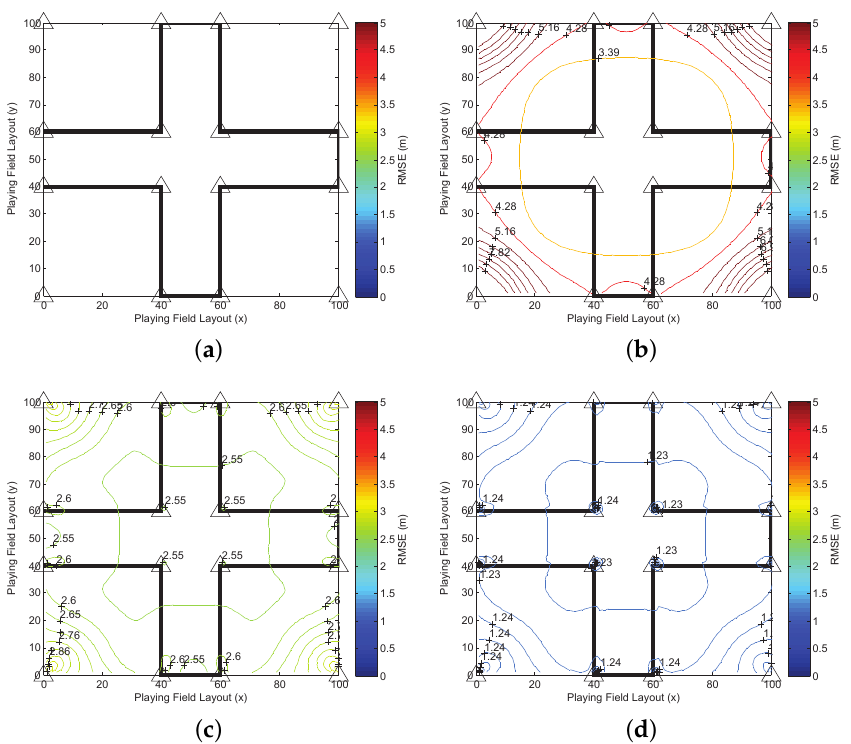
Figure 6. The simulation of a building layout. ( a ) Anchor deployment of the playing field; ( b ) the SPED of CRLB x ; ( c ) the SPED of CRLB k t , l ; ( d ) the SPED of CRLB x t , k t , l x t , k t , l x t , k t , l t , k t , l